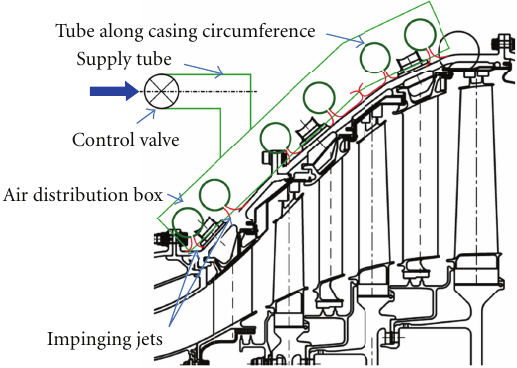
Figure 2: Scheme of a LPT ACC system, Ahmed et al.